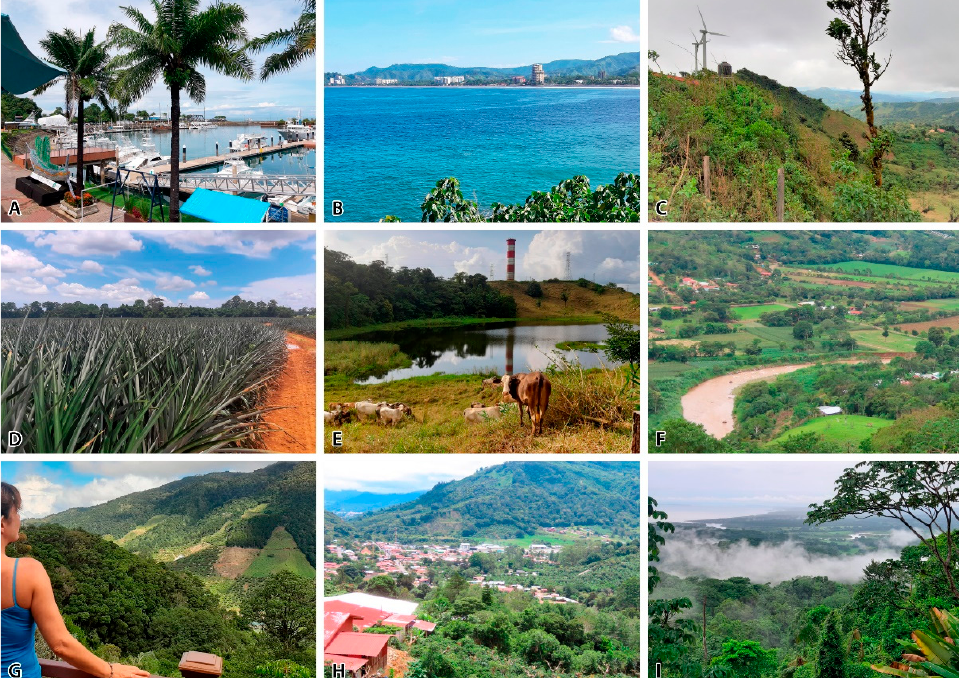
Figure 9. Sites with typical landscape-scale pressures and their five-class assessments applying LAP: ( A ) new tourist development (Marina Quepos, site 6: Poor); ( B ) coastline tourism (Jacó, Site 5; Moderate); ( C ) recent agro-pastoral expansion, new roads, and wind farm (Cristo Rey Desamparados, near Empalme, Site 30: Poor); ( D ) pineapple monocultures with remnant riparian forests (near Siquirres, Site 40: Poor); ( E ) overgrazing and artificial structures marring the horizon (Laguna Maria Aguilar near Pao Vulcano, site 47: Poor); ( F ) agricultural intensification and sprawl with riparian zone degradation (near San Isidro de General, site 40: Poor); ( G ) upland small-scale agriculture and regenerating rangelands (Savegre headwaters, San Gerardo de Dota, site 26: Good); ( H ) traditional multi-use coffee-growing landscape (near San Rafael de Dota, site 29; Moderate); ( I ) regenerating heterogeneous semi-natural landscape (Tarcoles delta from Carara National Park, Site 4: Excellent). All photos by V. Vlami and S. Zogaris during the survey.